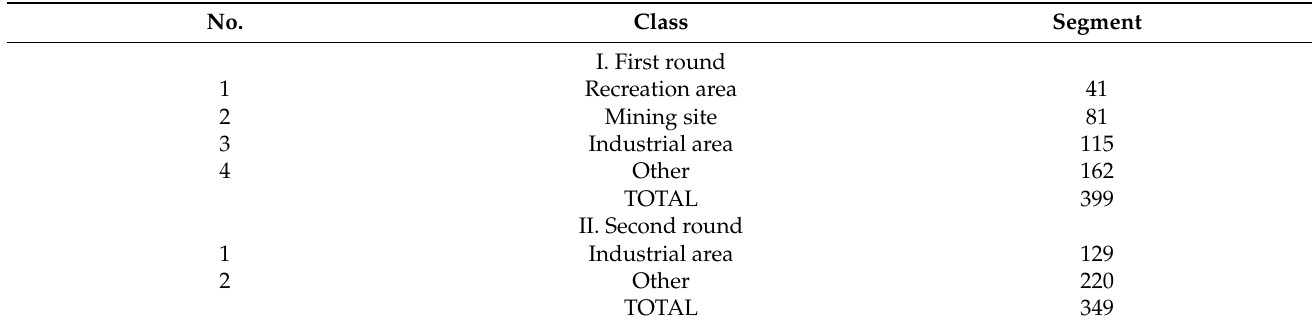
Table A3. Summary of training data for land use function regions.